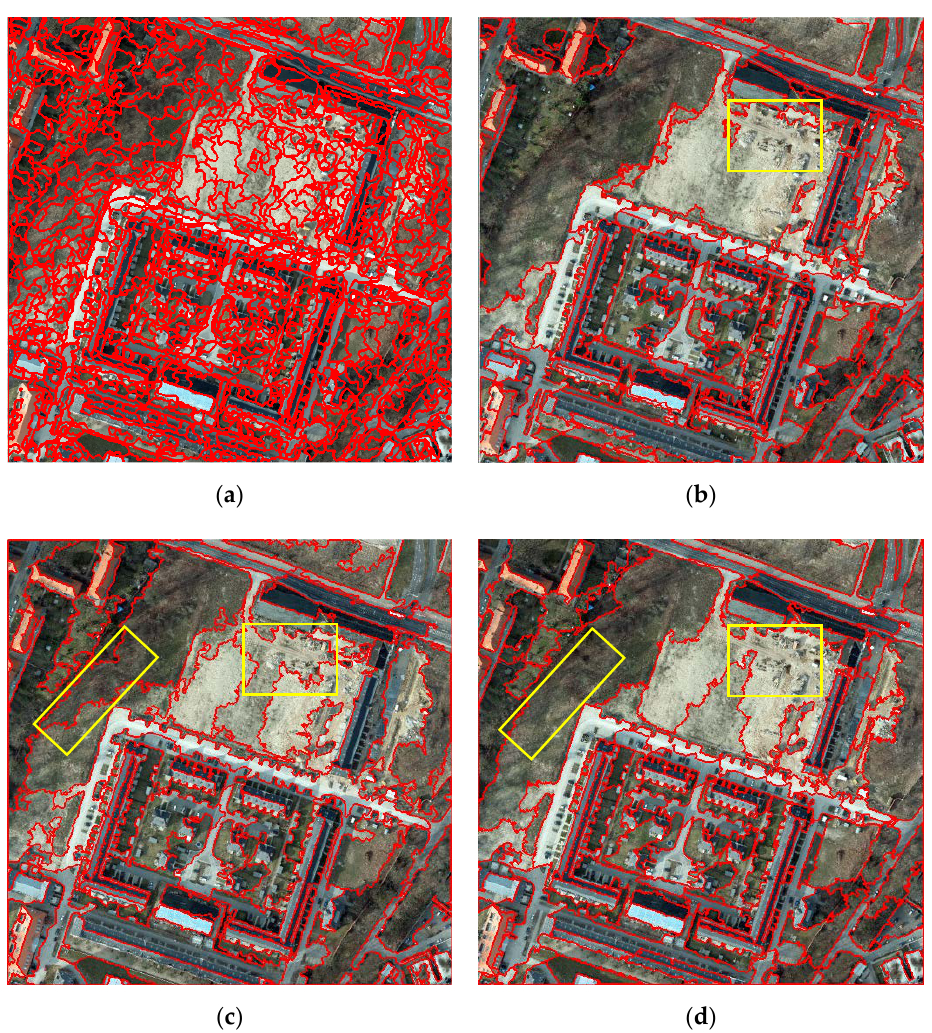
Figure 12. Segmentation results produced by different methods for the Potsdam aerial image (T4): ( a ) WTS; ( b ) MS; ( c ) MRS; ( d ) MMHS.